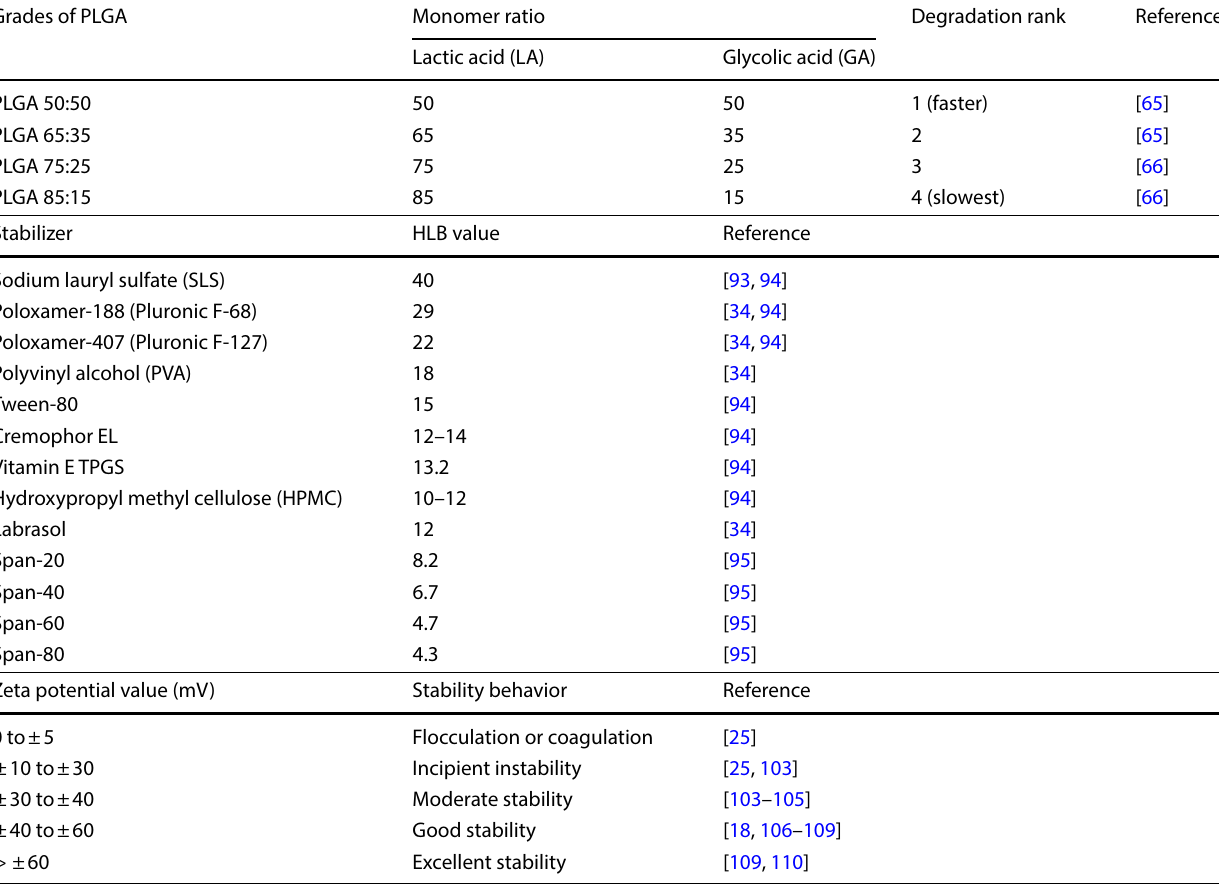
Table 1 List of different grades of PLGA and their monomer ratio and degradation rank; list of stabilizers and their HLB value used for the preparation of PLGA nanoparticles; PLGA nanoparticles based zeta potential value and their stability behavior remarks Grades of PLGA Monomer